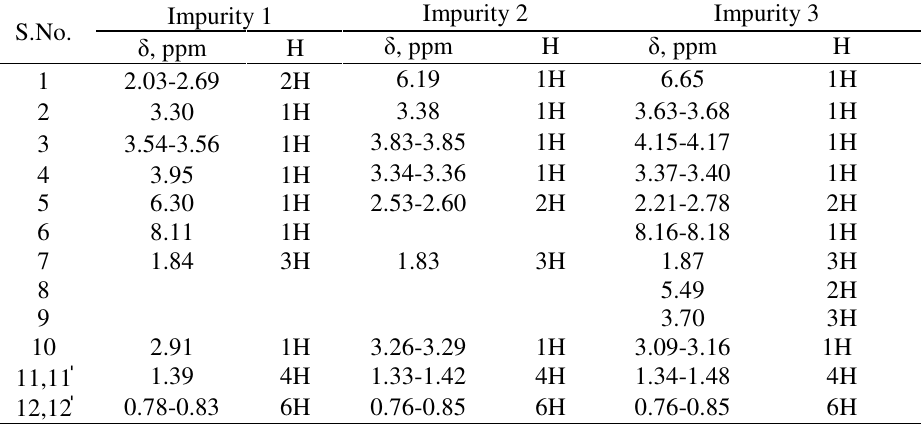
Table 2. 1 H NMR spectral data of impurities 1, 2 & 3